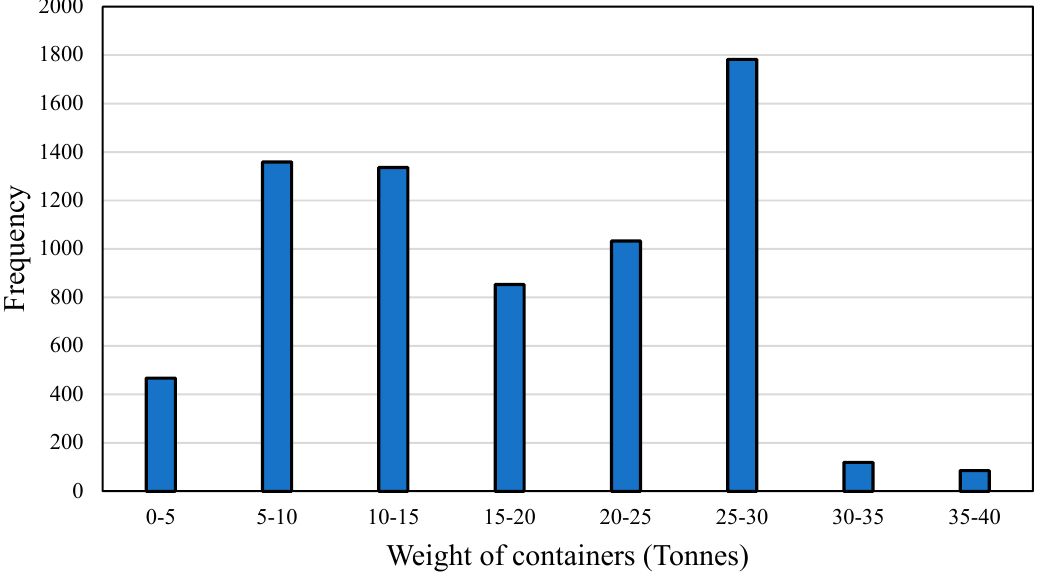
Figure 8. An example for the power losses of (a) the crane 1 and crane 2 (ESS model) and (b) AFE.